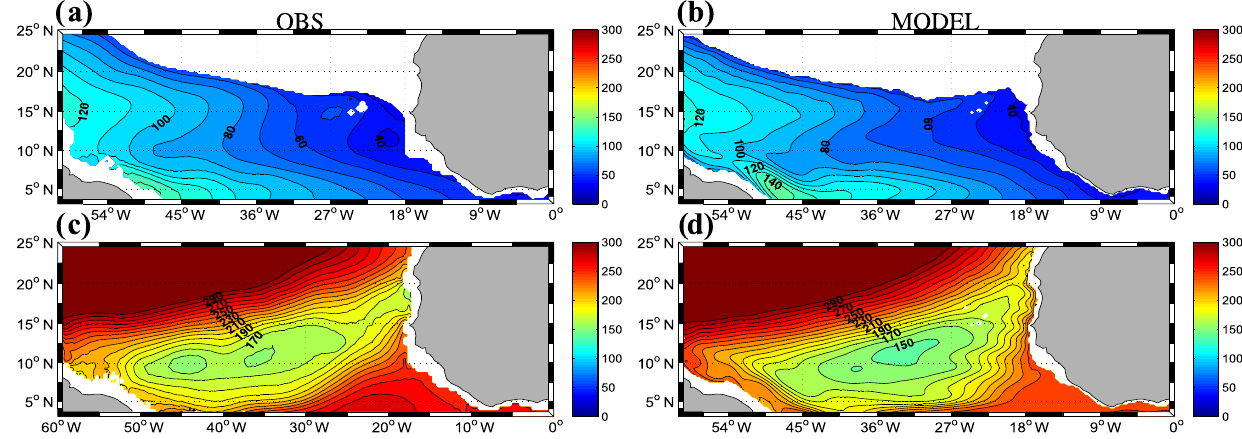
Figure 5. Depth (m) of the isopycnal density surface σ t = 25 . 2 (a, b) and σ t = 26 . 7 (c, d) in CORA (a, c) and TROP025 (b, d)